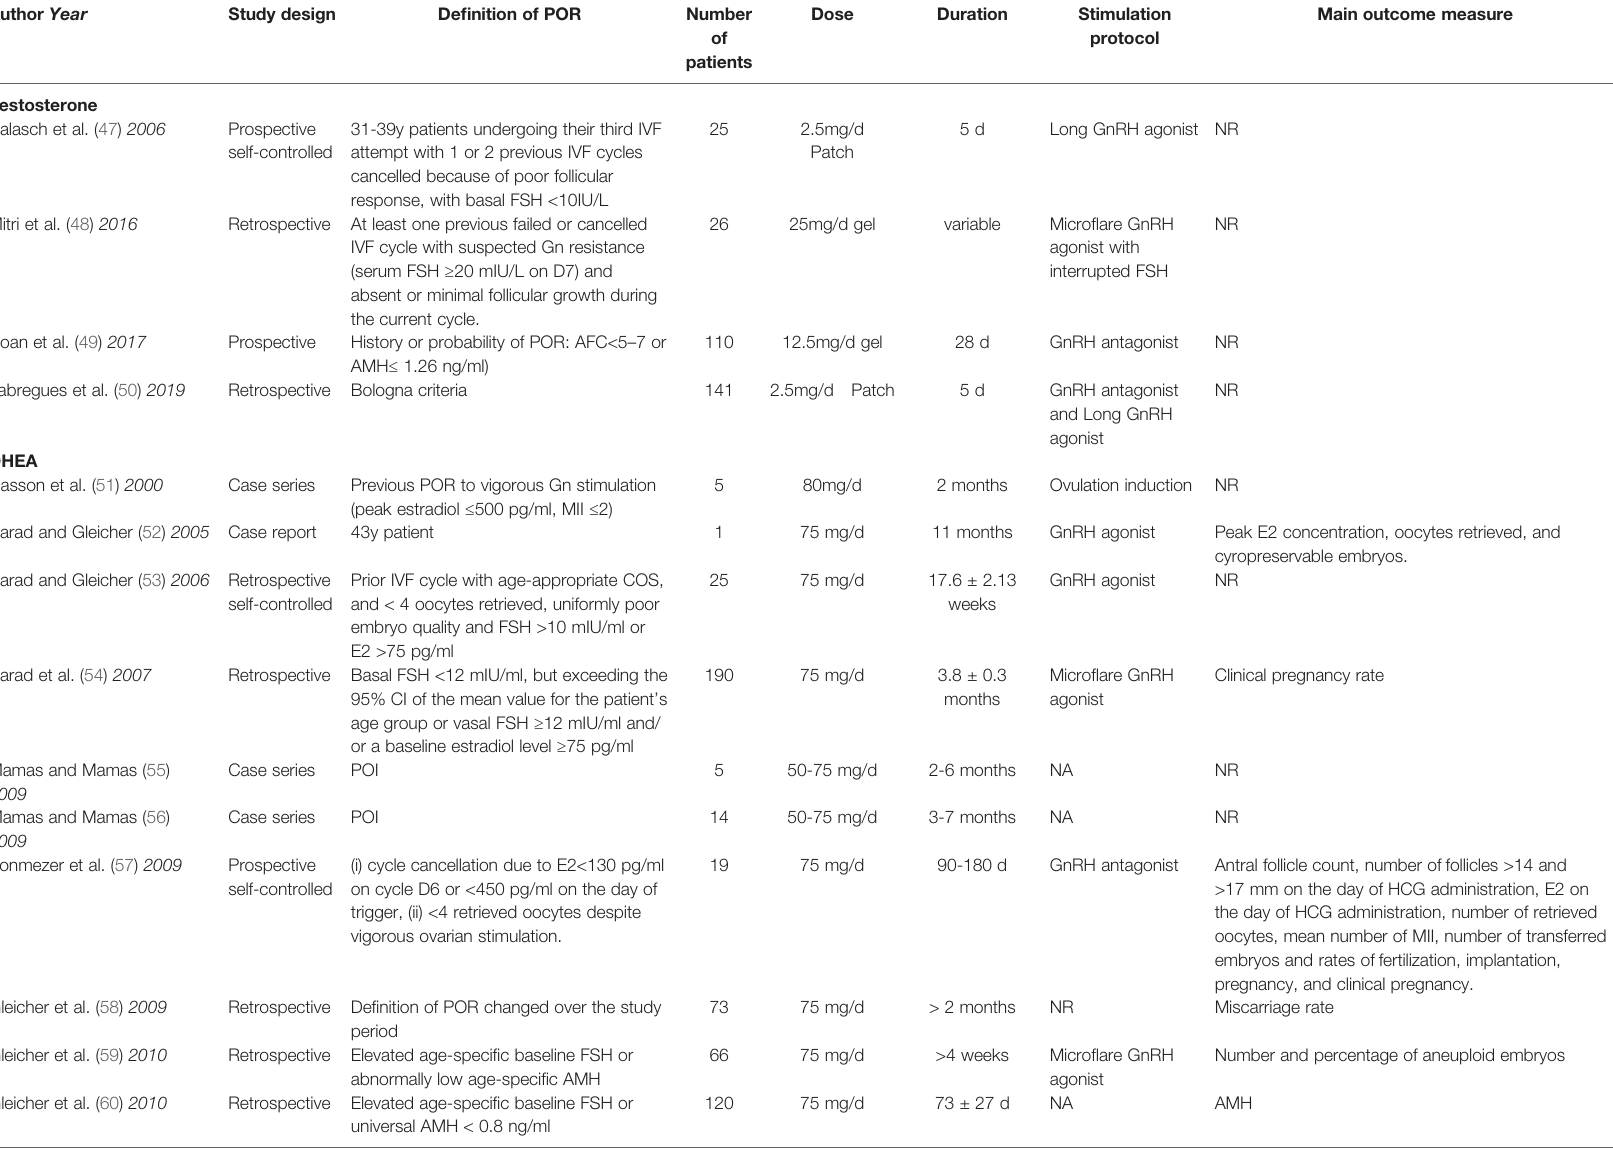
TABLE 2 | Published observational trials on the use of DHEA and Testosterone in DOR and POR patients. Author